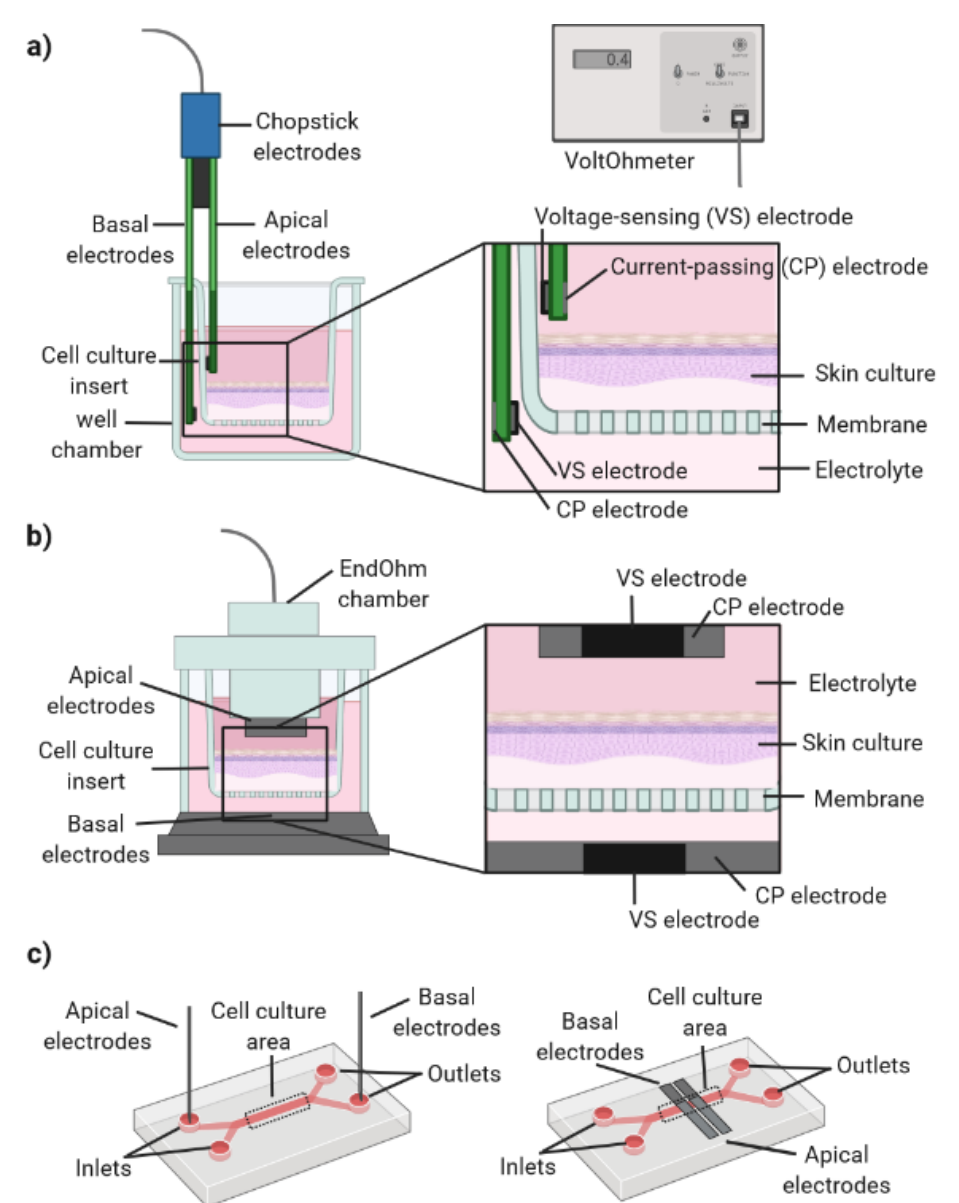
Figure 7. Transepithelial/transendothelial electrical resistance (TEER) measurements. ( a ) Using chopstick/STX2 electrode pairs connected to voltOhmeter and ( b ) using an EndOhm chamber. The uniformity of the current density generated by the electrodes across the cell layer has a significant effect on the TEER measurement. The chopstick electrodes cannot deliver uniform current density. As an alternative, the EndOhm chamber generates a more uniform current density. ( c ) TEER measurements performed on-chip by inserting electrodes on the chip inlets/outlets ( left ), in a process similar to the introduction of the chopstick electrodes. Electrodes integrated on-chip and placed closer to the cell culture chamber ( right ), in a process similar to the EndOhm chamber.